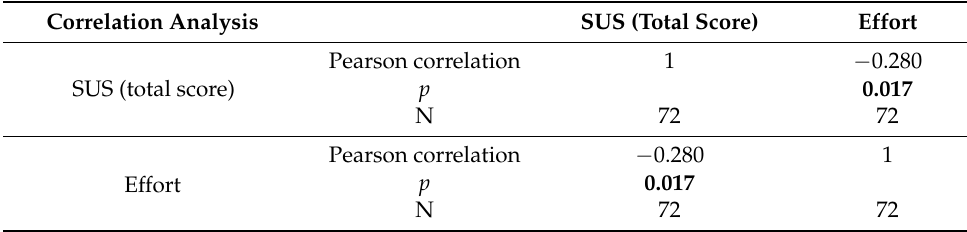
Table 11. Correlation analysis on system usability and